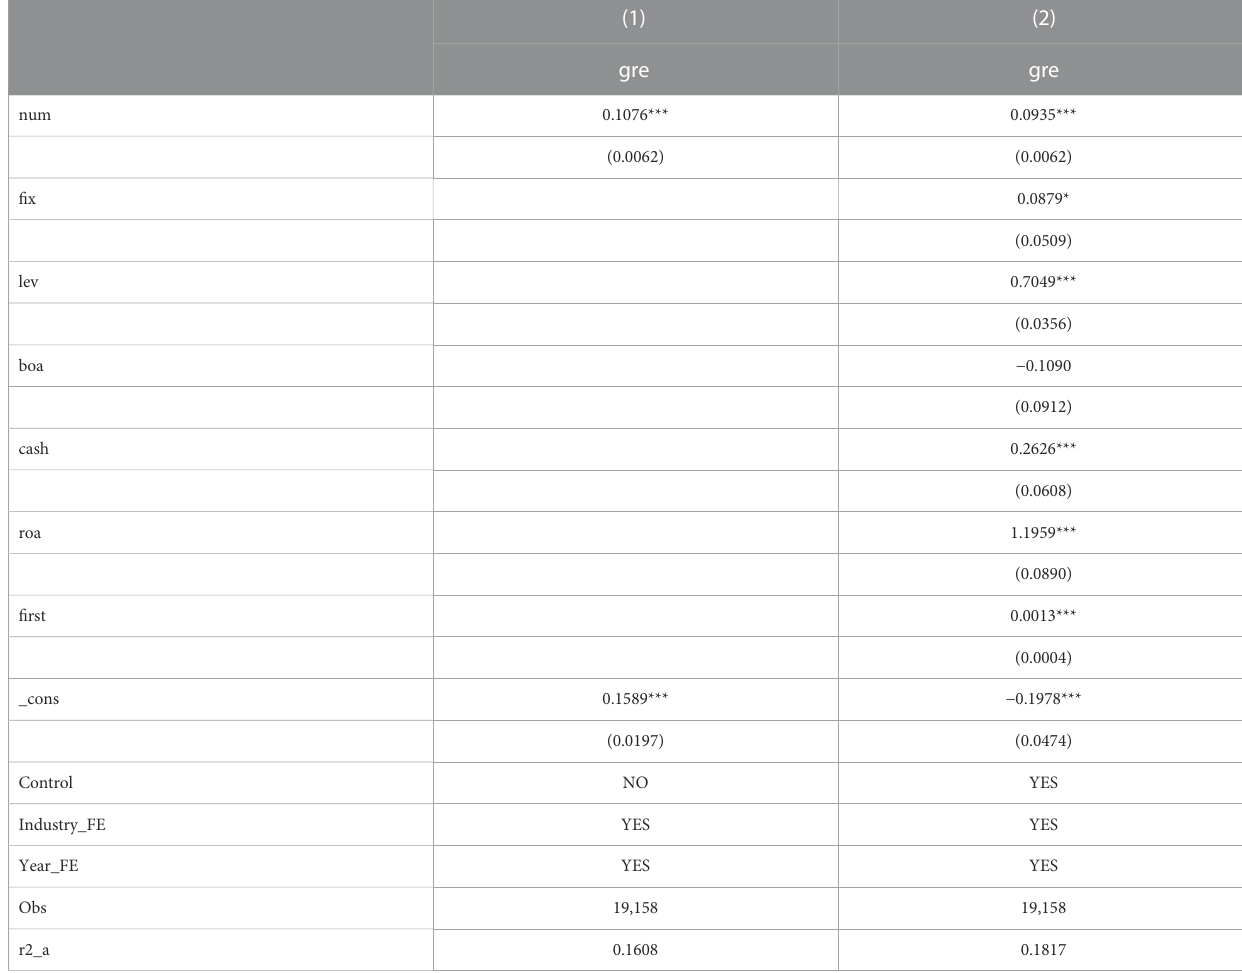
TABLE 3 Benchmark